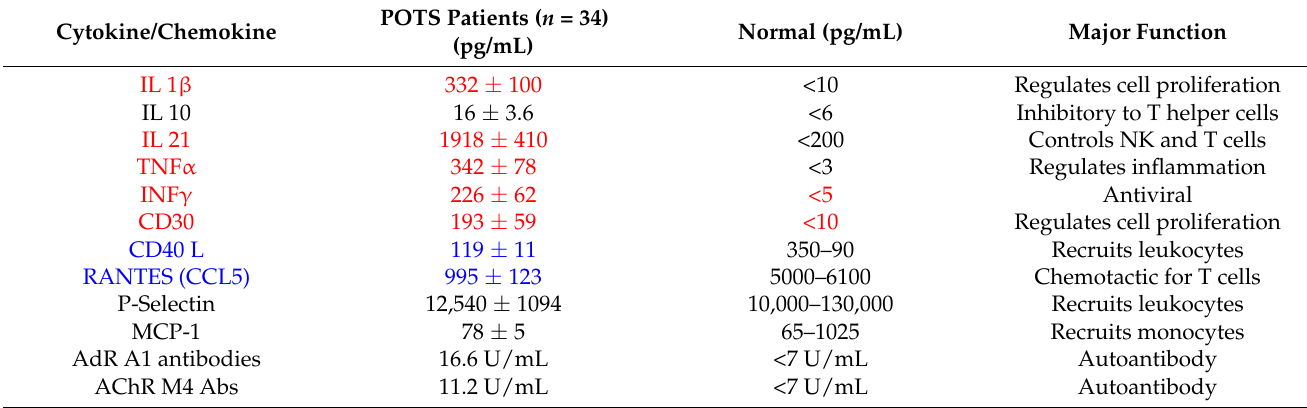
Table 2. Inflammatory cytokine and chemokine biomarkers in postural orthostatic tachycardia syndrome (POTS) patients with elevated adrenergic and muscarinic autoantibodies.